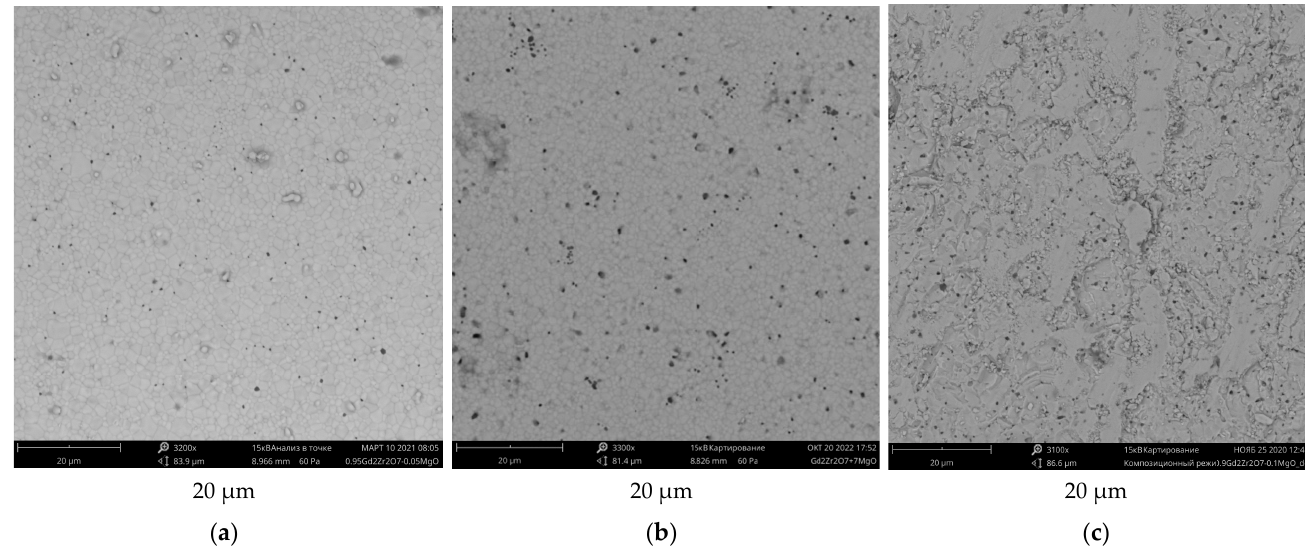
Figure 3. SEM images of (1- x )Gd 2 Zr 2 O 7 · x MgO samples at ( a ) x = 0.05; ( b ) x = 0.07; ( c ) x = 0.10.